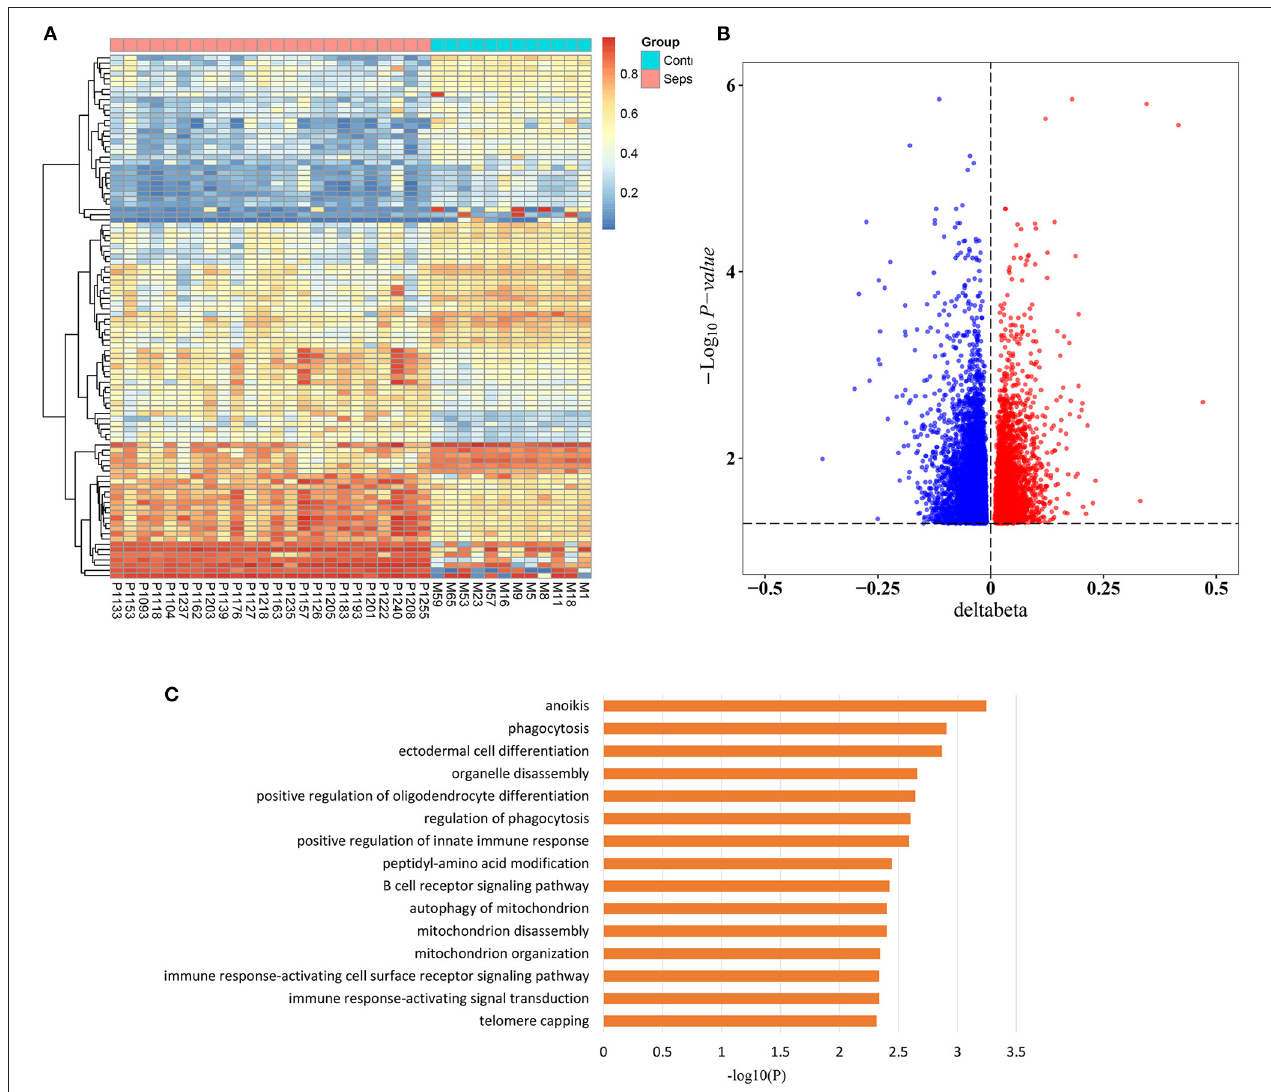
( Supplementary Table 2 ). The top 100 MVPs are shown as an expression heatmap ( Figure 1A ). Principal component